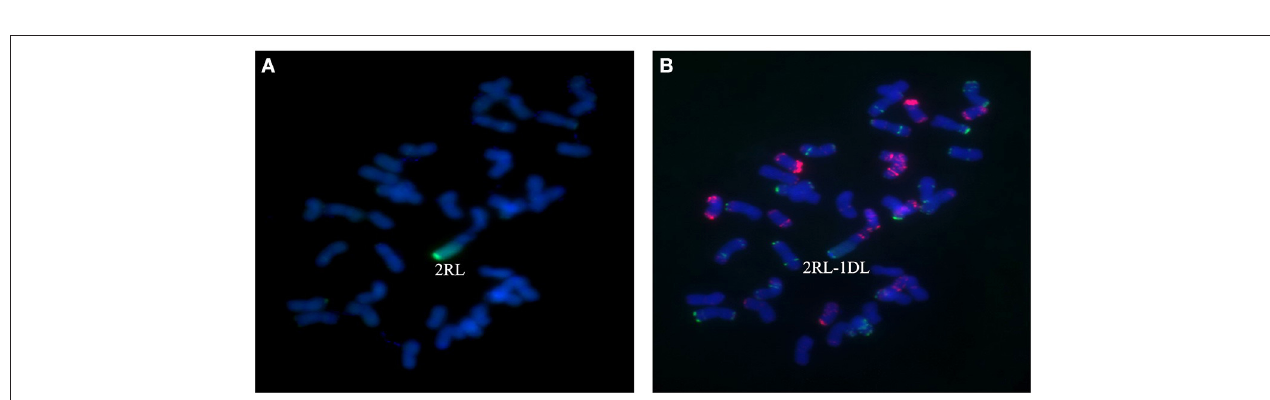
FIGURE 7 | Chromosome composition of BC 2 F 3 line 1,887 by FISH (B) and GISH (A) using probe pAs1 (red) and probe pSc119.2 (green). Line 1,887 was shown to be a monosomic 2RL-1DL translocation line in which the long arm of 2R was translocated to the long arm of 1D chromosome.